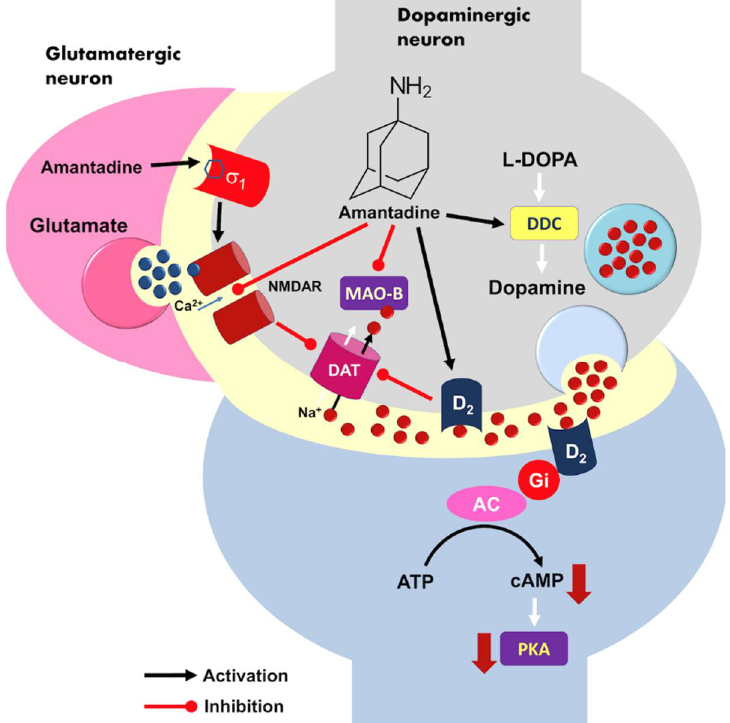
Figure 1. A model of possible molecular mechanism of amantadine action at the level of brain do- paminergic signaling. Activation of presynaptic dopamine receptor D2 may reduce dopamine trans- porter 1 (DAT1) activity in response to high neurotransmitter and elevates dopamine level within synaptic cleft. D2 is a Gi-coupled receptor, its excitation causes an inhibition of the adenylyl cyclase (AC) activity, decreased cAMP production and finally silencing of protein kinase A (PKA)-depend- ent neuronal signaling pathway. Amantadine is also able to inhibit monoaminoxidase B (MAO-B) but it does support L-DOPA decar-boxylase (DCC) activity in the presynaptic neuron. DDC—L- DOPA decarboxylase; MAO-B—monoaminoxidase B; DAT—dopamine transporter; AC—adenyl cyclase; PKA—protein kinase A. So far, there is only one report in the medical literature on the possibility of improv- ing primary sexual dysfunctions in schizophrenia with amantadine [16]. This problem has not been studied for 23 years. Since the problem of the lack of desire and other sexual dysfunctions is common and requires new pharmacological methods to help patients, the authors decided to describe a series of cases of male patients diagnosed with schizophre- nia, who were treated with amantadine due to complete loss of sexual desire and activity. 2. Results Adding amantadine to antipsychotic treatment significantly improved sexual func- tion in all CSFQ subscales in all patients. The greatest improvement was observed in the Desire/frequency subscale—patients had an average score 2.4 times higher than at the be- ginning of the treatment (F(2,8) = 105.41; p < 0.001; eta 2 = 0.963). After 3 months of admin- istration of amantadine, the Orgasm/completion subscale was also 1.7 times better (F(2,8) = 41.75; p < 0.001; eta 2 = 0.913). The improvement in the other subscales was similar—pa- tients achieved mean scores 1.2–1.3 times higher than the baseline values (for Desire/in- terest subscale: F(2,8) = 60.88; p < 0.001; eta 2 = 0.938; for Arousal/excitement subscale F(2,8) = 70.58; p < 0.001; eta 2 = 0.946). Figure 2 shows the mean scores of all patients on the CSFQ subscales in relation to the values obtained at Visit 1, and Table 1 presents the statistical significance of improvement between the first and the last visit. Additionally, Table 2 pre- sents the results in individual subscales of the patients ’ CSFQ scale at subsequent visits.